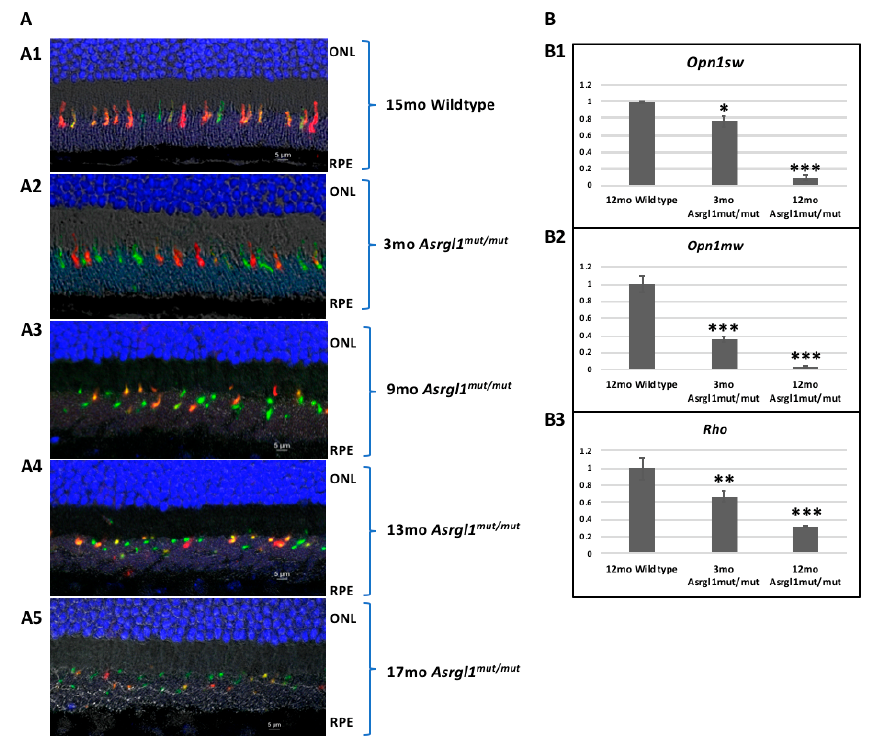
Figure 5. Expression of photoreceptor markers in Asrgl1 mut/mut mice: ( A ) Immunostaining of photoreceptor markers in Asrgl1 mut/mut mice: retinal sections were stained with OPN1MW/M-opsin (green) and OPN1SW/S-opsin (red). Nuclei were stained with DAPI. ( A1 ) Fifteen-month-old wildtype mice. Retina of ( A2 ) 3-, ( A3 ) 9-, ( A4 ) 13-, and ( A5 ) 17-month-old Asrgl1 mut/mut mice. Outer segments of OPN1MW and OPN1SW expressing cones are severely abnormal in Asrgl1 mut/mut mice. ( B ) Levels of expression of photoreceptor marker genes in Asrgl1 mut/mut mice: levels of retinal cell marker transcripts were measured by qRT PCR in 3- and 12-month-old Asrgl1 mut/mut mice and 12-month-old wildtype mice retinal tissue. ( B1 ) Significant decrease in the expression of Opn1sw ( p = 0.0008 for 12 months and p = 0.0165 for 3 months) was observed in Asrgl1 mut/mut mice compared with wildtype controls. The p values < 0.05, and 0.001 are indicated with *, and ***, respectively. ( B2 ) Expression of Opn1mw is significantly lower ( p < 0.0001 for 12 months and p = 0.0004 for 3 months) in Asrgl1 mut/mut mice compared with that in wildtype controls. The p value < 0.001 is indicated with ***. ( B3 ) Significant decrease in the expression of rhodopsin ( p = 0.0008) was observed in 12-month-old Asrgl1 mut/mut mice compared with age-matched wildtype mice. The p values < 0.01, and 0.001 are indicated with **, and ***, respectively.